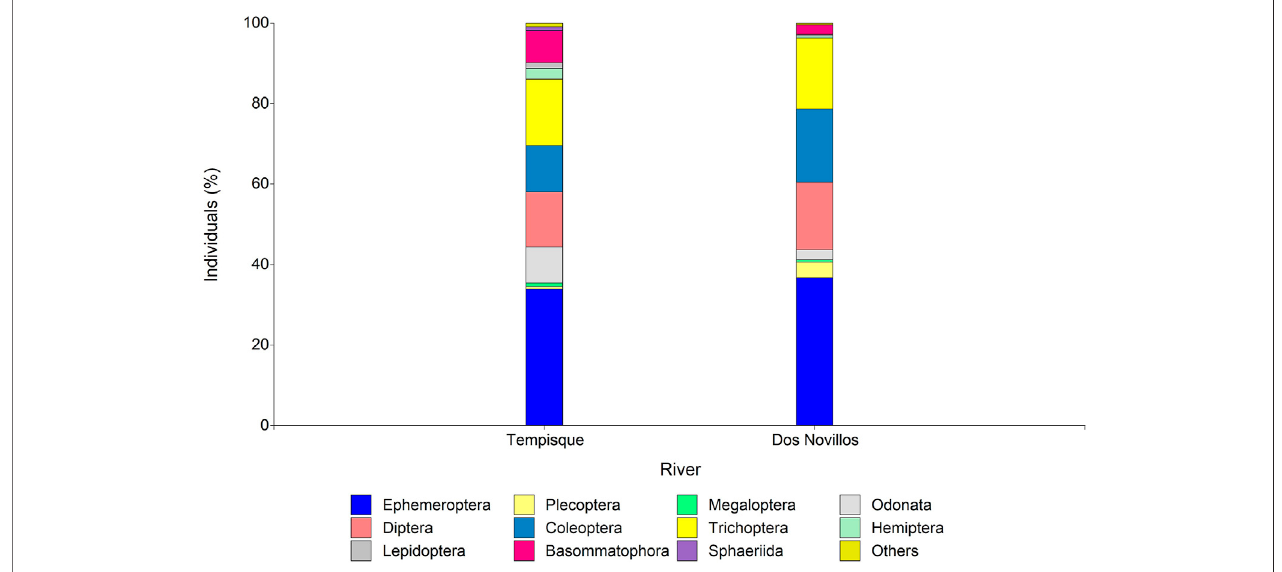
FIGURE 10 | Abundance percentage per order at the Tempisque and Dos Novillos river basins.